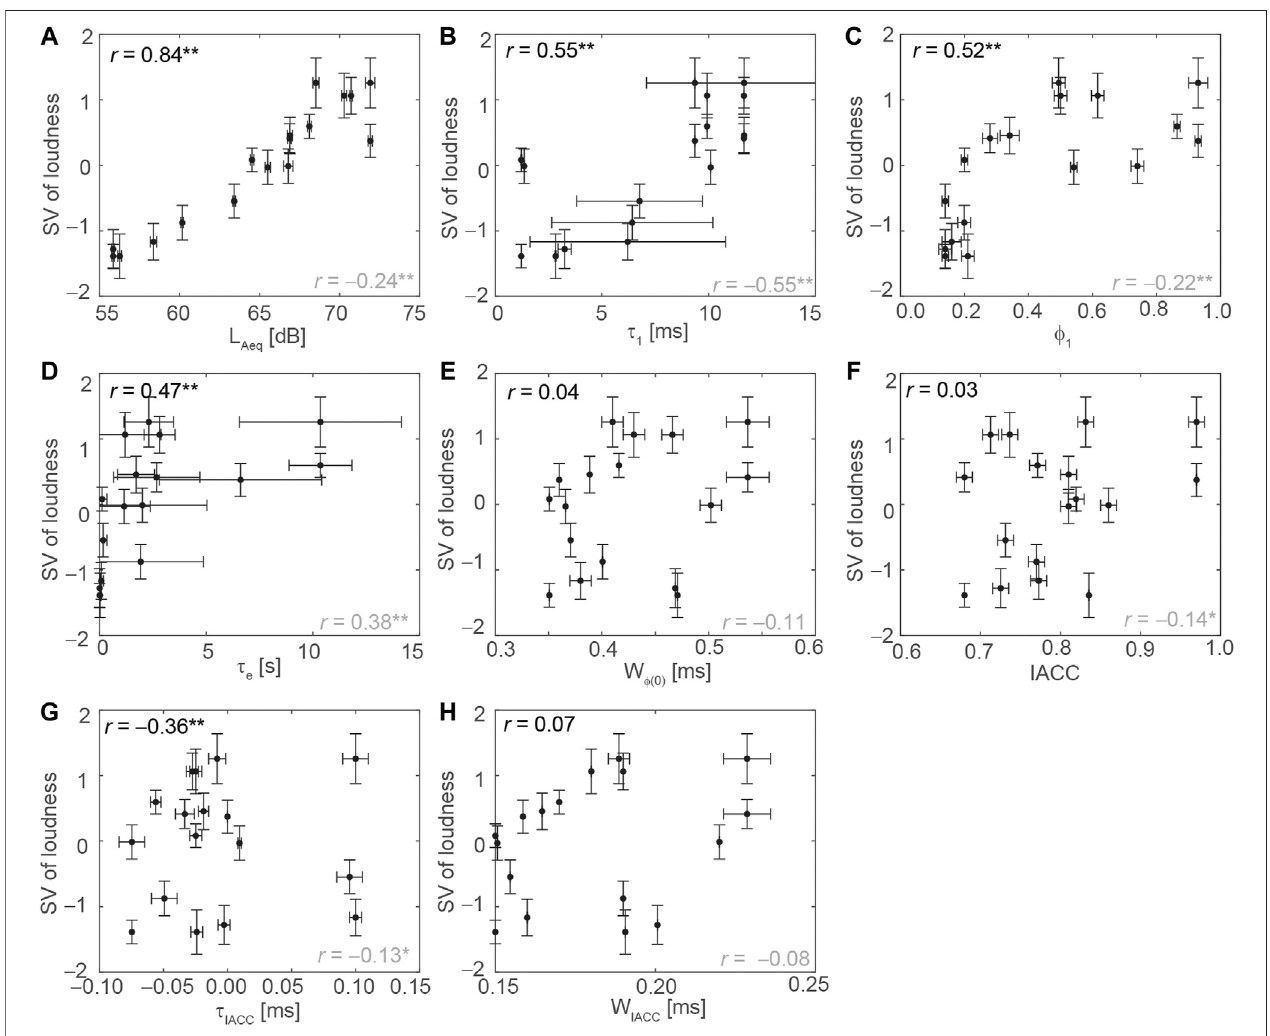
FIGURE 6 | Relationship between correlation parameters and the scale values of loudness. (A) L Aeq , (B) τ 1 , (C) ϕ 1 , (D) τ e , (E) W ϕ (0) , (F) IACC, (G) τ IACC , and (H) W IACC . The symbols indicate the mean values and the error bars indicate the SDs. The correlation coef fi cients of the mean and SDs are shown in black and gray, respectively. Asterisks represent the level of signi fi cance, i.e., ** p < 0.01, * p < 0.05.